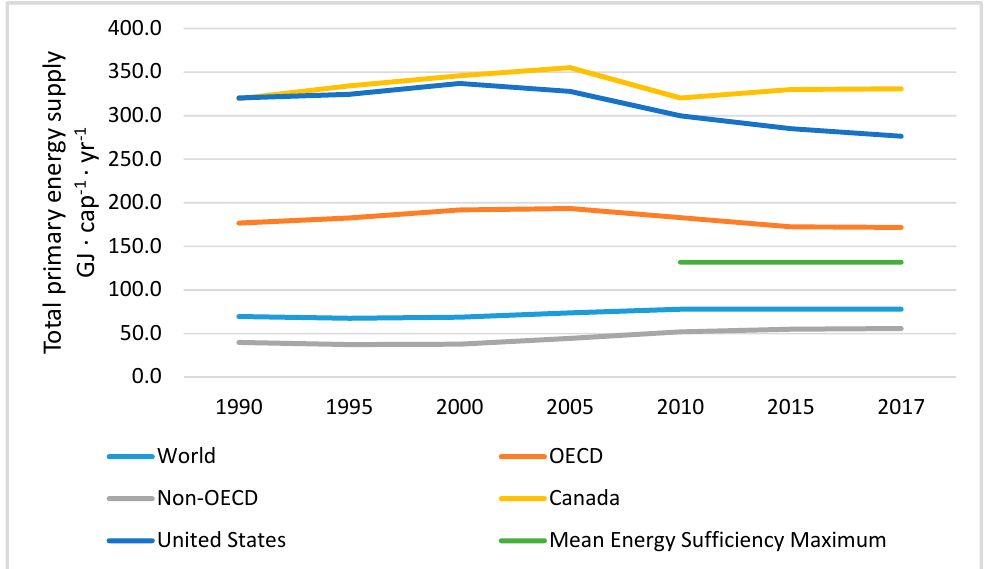
Figure 2. Comparison of energy sufficiency and energy use by country or region 1990 – 2017. GJ ∙ cap − 1 ∙ yr − 1 : gigajoules per capita per year; OECD: Organisation for Economic Co-operation and Development. Source of data: International Energy Agency data services < https: // www.iea.org / subscribe-to-data- services / world-energy-balances-and-statistics >